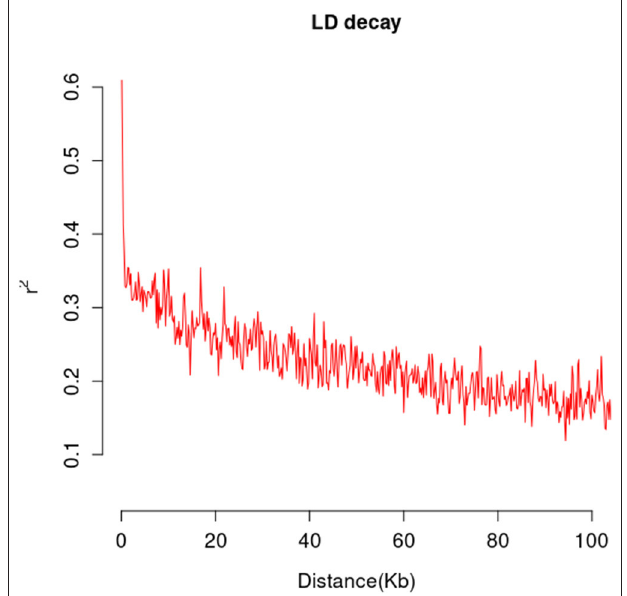
FIGURE 6 | The mean LD decay rate was estimated by the squared allele frequency correlations ( r 2 ) using all pairs of SNPs located within 100kb of physical distance in genomic regions in a population of 226 sunflower accessions.